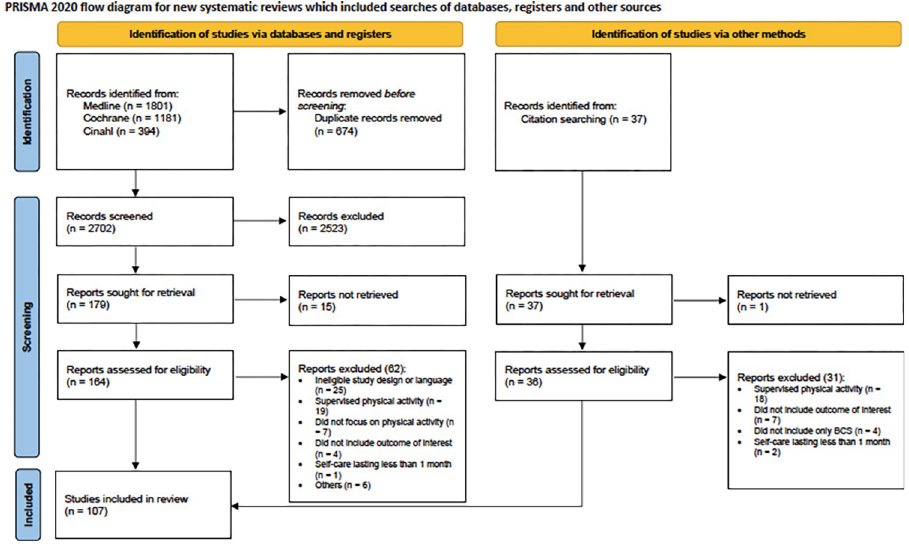
Fig 1. Flow chart of the search